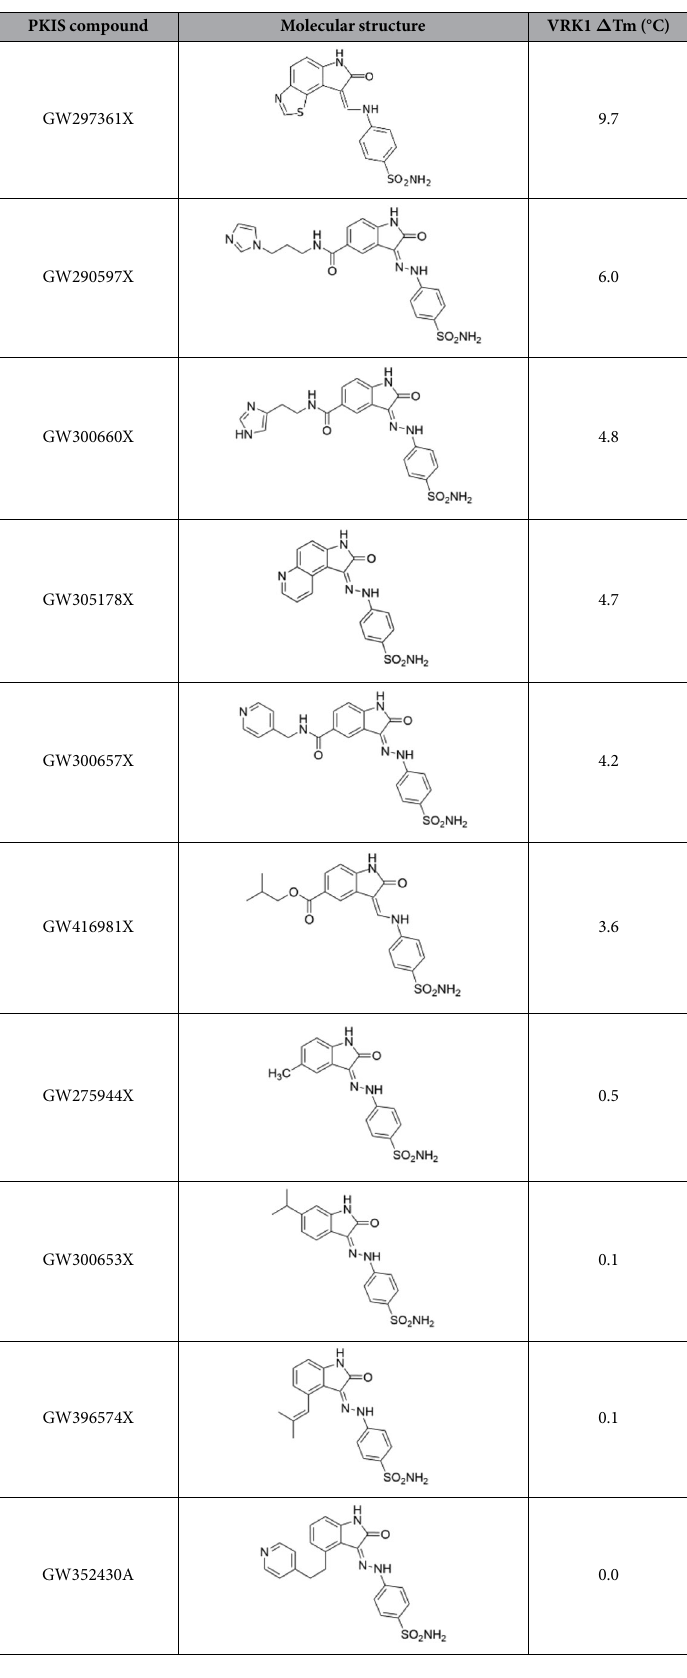
Table 1. Structure-activity relationship of selected compounds from the oxindole